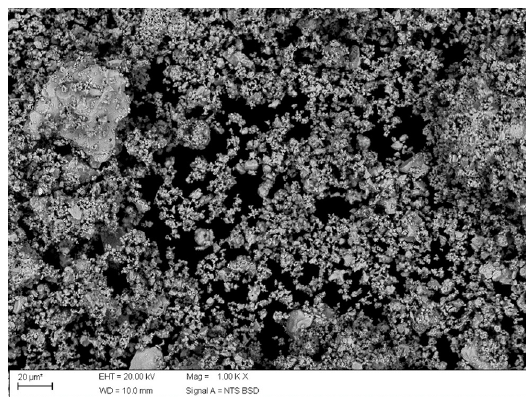
Figure 2. Powder of niobium